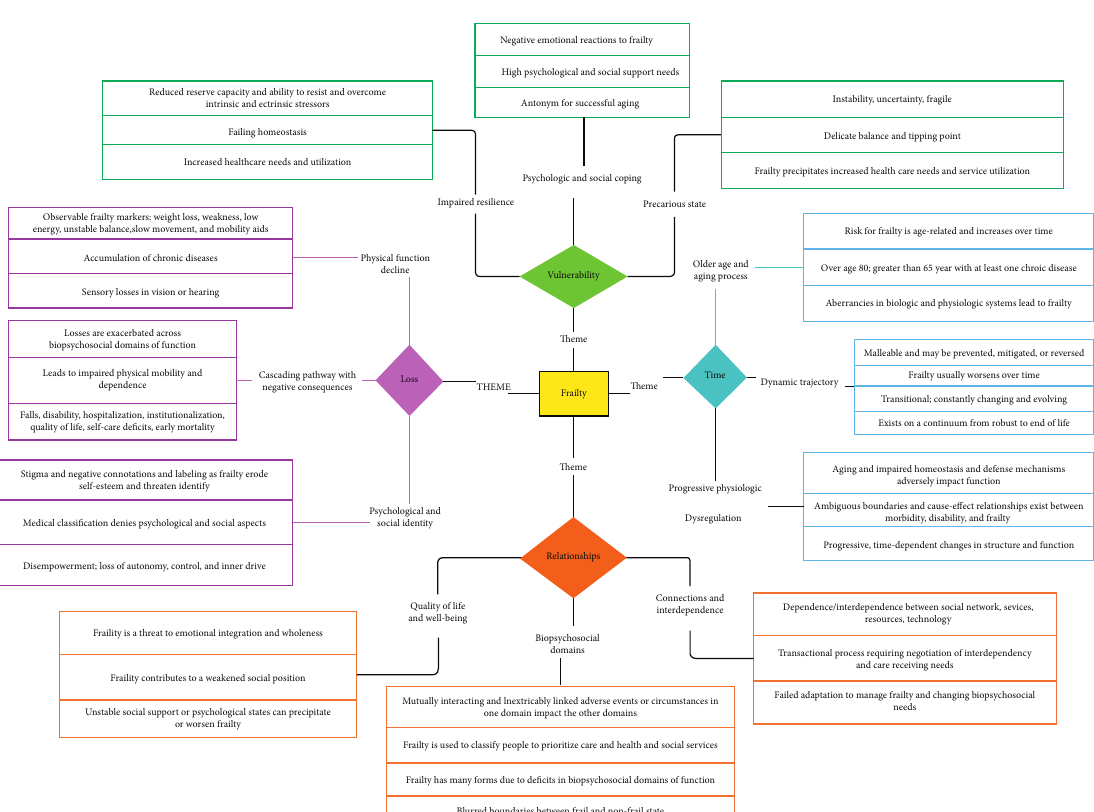
Figure 3: Concept map for frailty from the